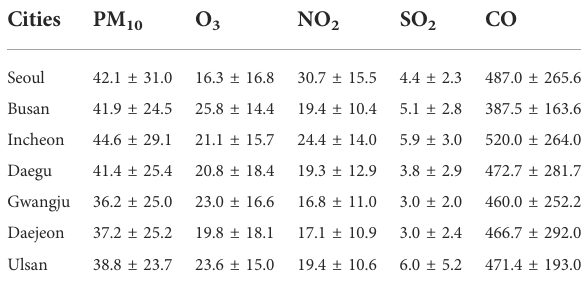
TABLE 1Medianconcentrations of PM 10 ( μ g m − 3 ), O 3 (ppb), NO 2 (ppb),